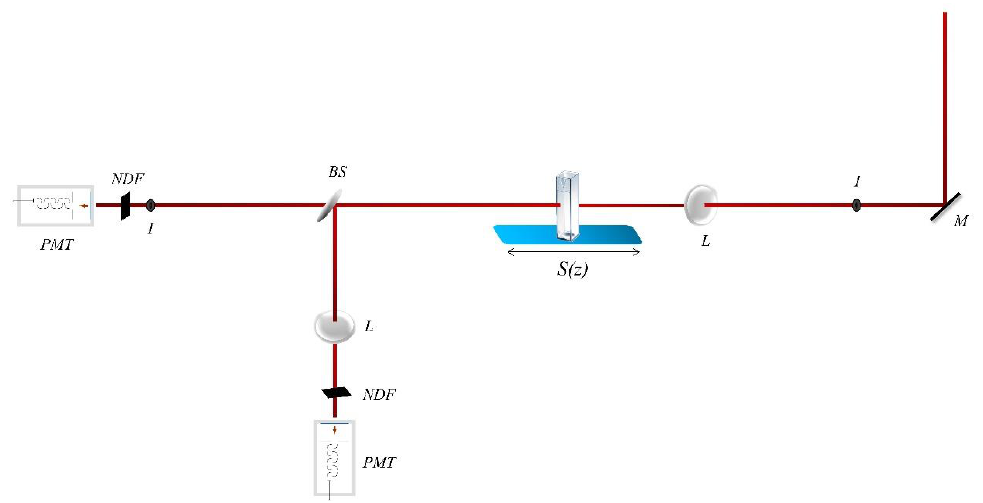
Figure 1. Configuration of the Z-scan technique.